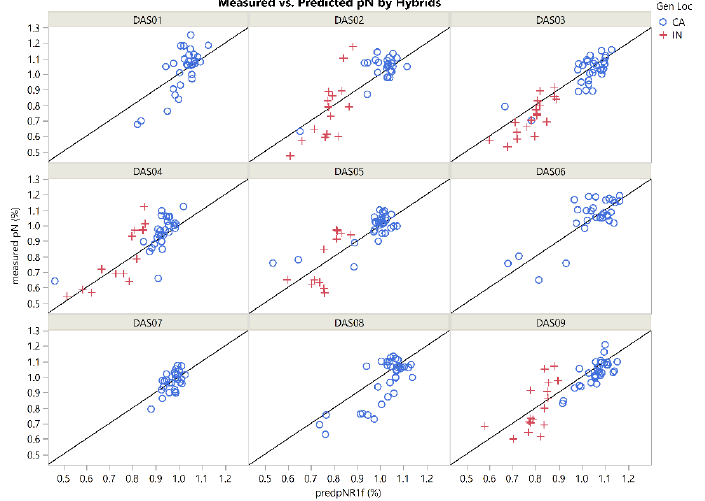
Figure 7. Measured by predicted plot for Full R1 PLSR model for predicting N concentration (pN, %) separated by hybrid with general location indicated by color and marker shape. Black line is 1:1 reference line.